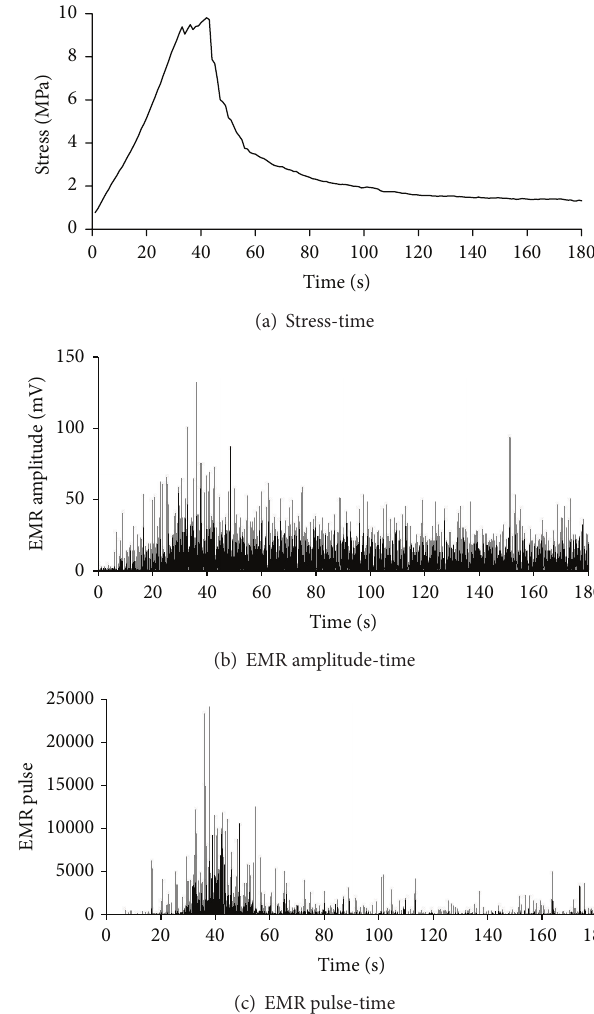
only 11 faults whose throws are between 2.0 m and 15.0 m are